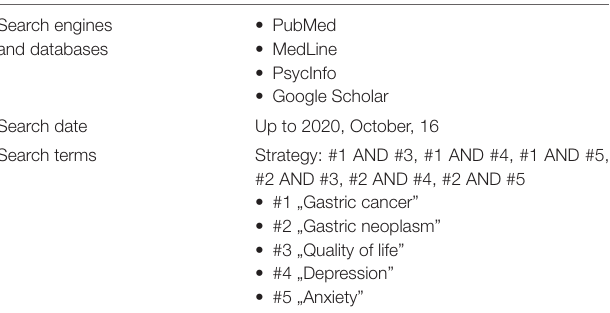
TABLE 1 | The search strategy of the research. Search engines and